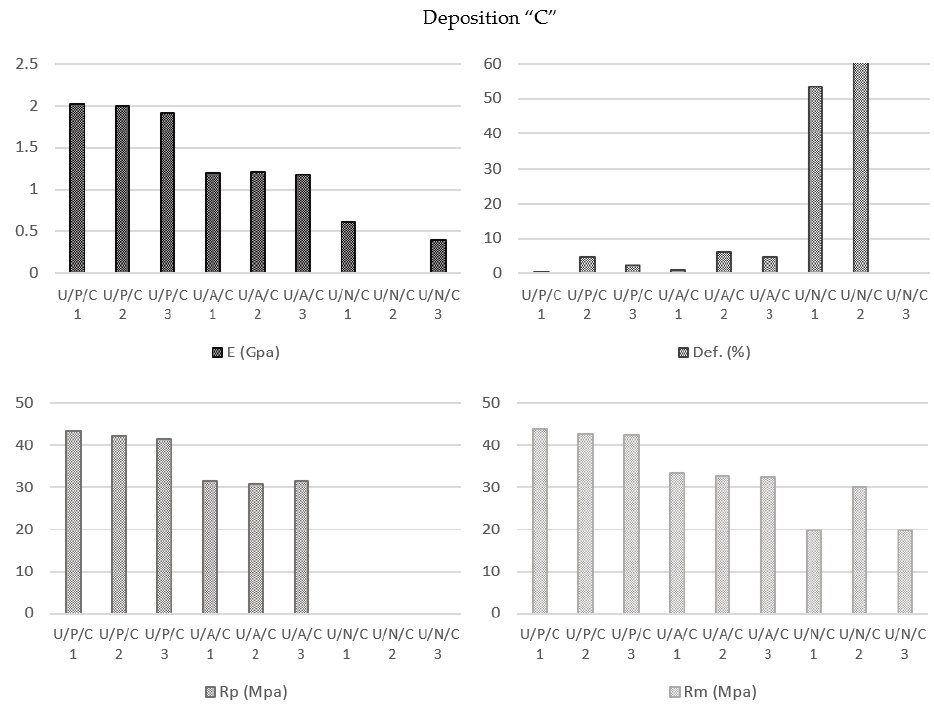
Figure 10. PLA, ABS, and Nylon specimens with Deposition pattern “C” parameters average values. When the deformation was approximately 10%, an initial tear in the shape of a “V” appeared as a result of the fiber structure formed in the zone near the transition radius. From this point, the printing lines became parallel to the load axis, increasing the tensile strength of the material, and finally reaching its definitive rupture point. The initial tear could be considered the effective breakage point of the sample (Figure 11).